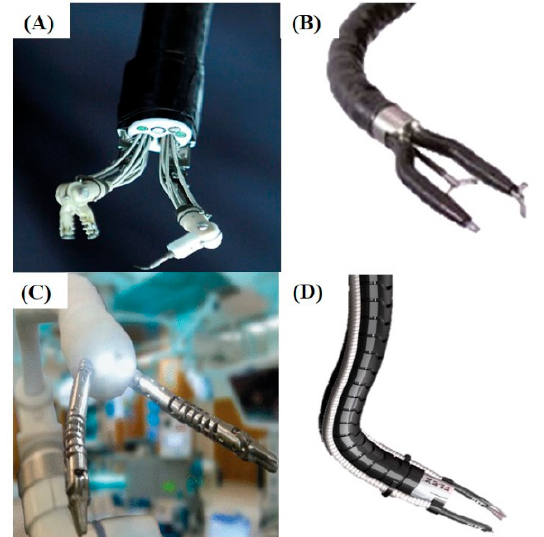
Figure 3. Novel flexible robots: ( A ) EndoMaster’s robotic system (EndoMaster Pte, Singapore) [67]; ( B ) ENDOSAMURAI TM Olympus Medical Systems Corp. (Tokyo, Japan) [69]; ( C ) i 2 Snake robot [70,71]; ( D ) Flex ® Robotic System (Medrobotics Corp., Raynham, MA, USA; courtesy of Medrobotics Corp.)